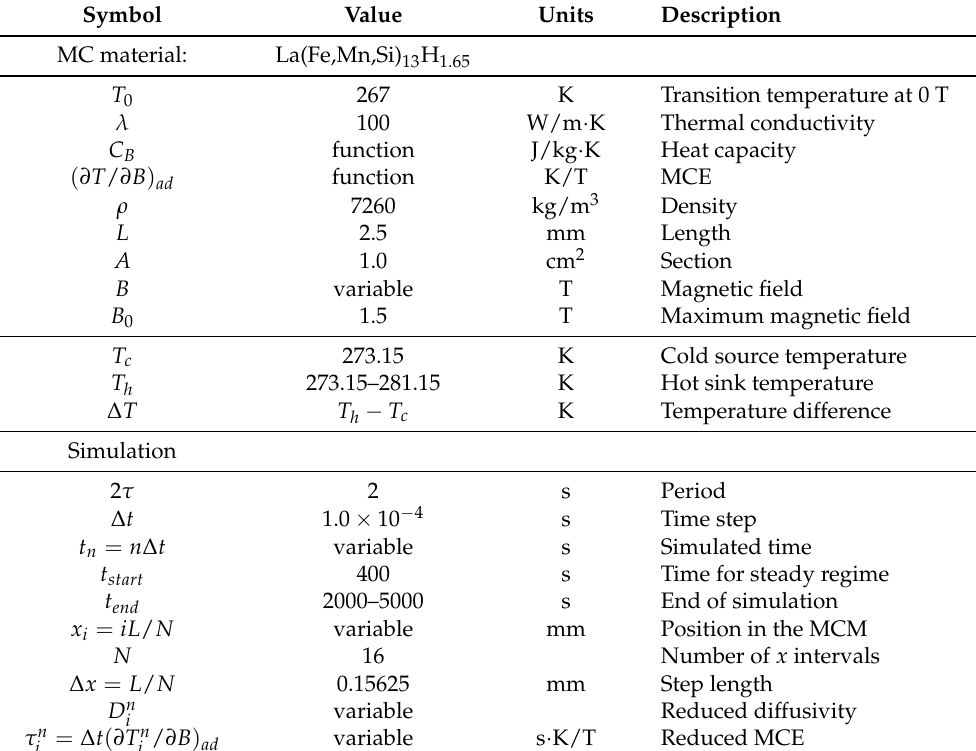
Table 2. Typical parameters used in the numerical simulation. The parameters which cover a range of values, except t end , can vary slowly and linearly with time from t start to t end . Symbol Value Units Description MC material: La(Fe,Mn,Si) 13 H 1.65 T 0